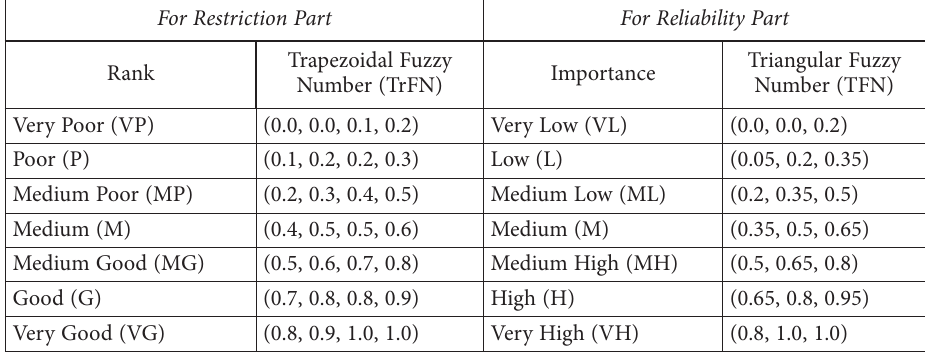
Table 4. Fuzzy linguistic terms and correspondent fuzzy numbers of each alternative